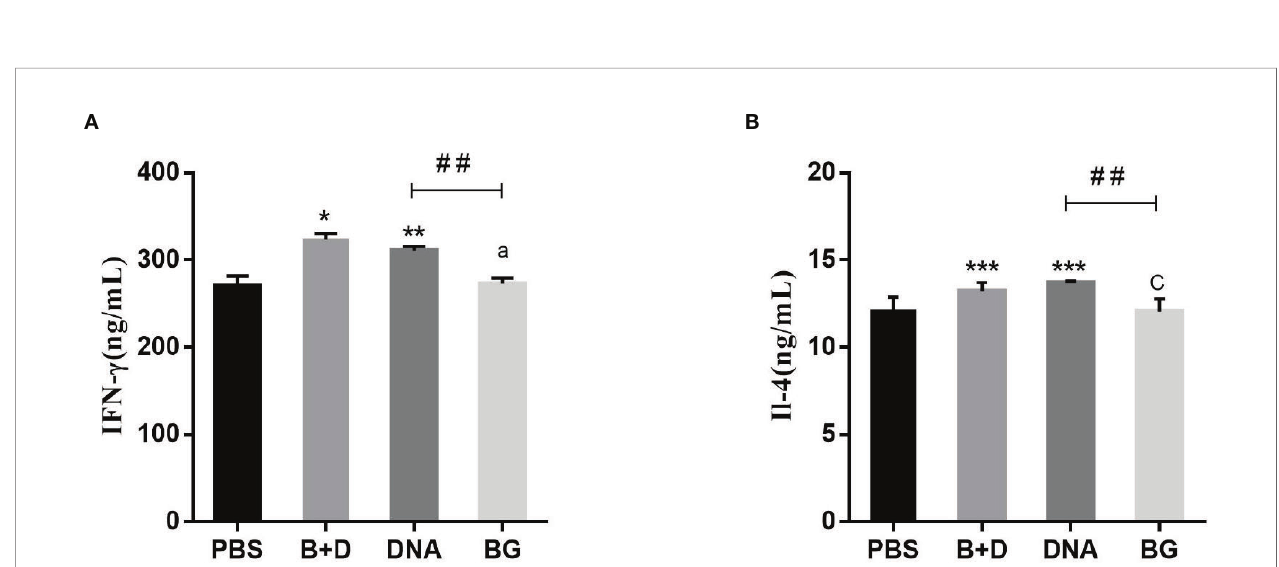
FIGURE 13 | Effect of DNA loaded by immune BGs on Th1 and Th2 cytokines. Serum samples were collected at 24 h after immunization. (A) IFN – g level and (B) IL – 4 level. Values are expressed as the mean ± SD of four individual experiments. Signi fi cance of differences between PBS, BG+DNA, DNA, and BG groups is represented as follows: *P < 0.05, **P < 0.01, ***P < 0.001. Letter indicates signi fi cant differences between BG +DNA, DNA, and BG group: a P < 0.05, b P < 0.01, c P < 0.001. #Asterisk indicated signi fi cant difference between DNA groups and BG groups: # P < 0.05, ## P < 0.01, ### P <